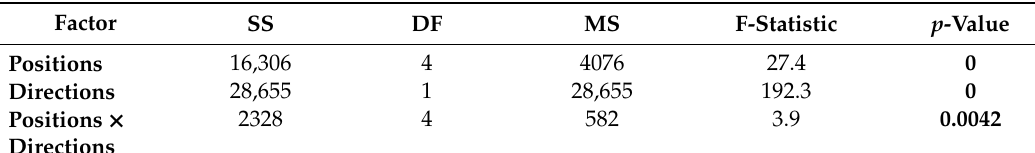
Table 6. Interactions of factors assessed.